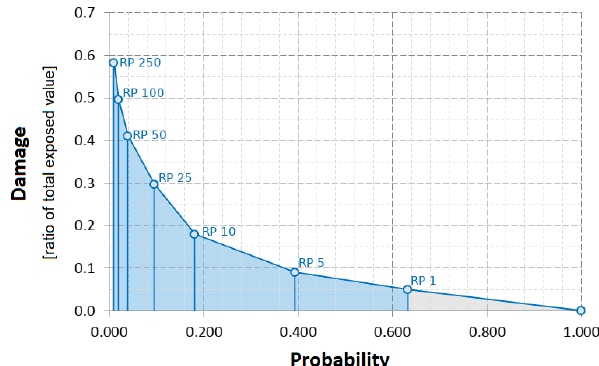
Figure 6. Schematic representation of the numerical integration of the damage function D(p) with respect to the exponential proba- bility of the hazard events. Damage ( y axis) represents the ratio of damage to the total exposed value estimated up to the most extreme scenario (RP 250 years). Events with a probability of occurrence higher than once in a year are expected to not cause damage (grey